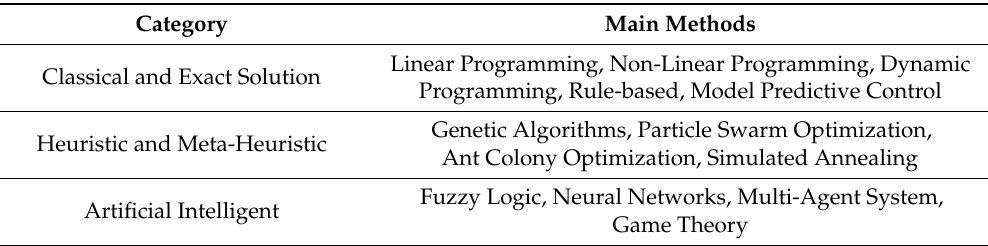
Table 3. Main methods for EMS optimization